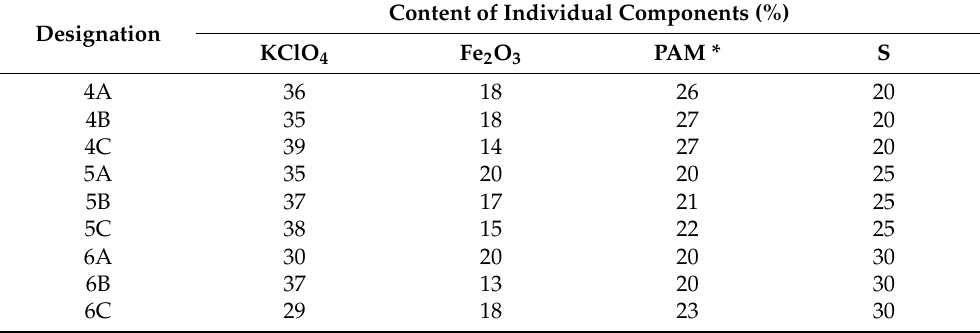
Table 2. The percentage content of components of prospective pyrotechnic compositions from the M-1 group, obtained using mathematical modelling